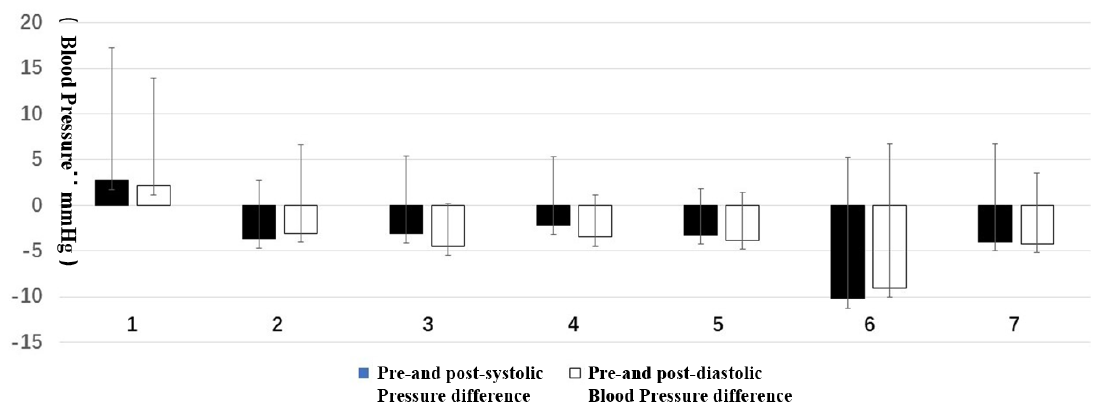
Figure 5. The mean of the amount of change ( ∆ D) of systolic blood pressure (SBP) and diastolic blood pressure (DBP): ( 1 ) structure, ( 2 ) wood, ( 3 ) wood with bench, ( 4 ) wood with platform and bench, ( 5 ) platform with trees, ( 6 ) waterfall with trees, and ( 7 ) pool with plants.